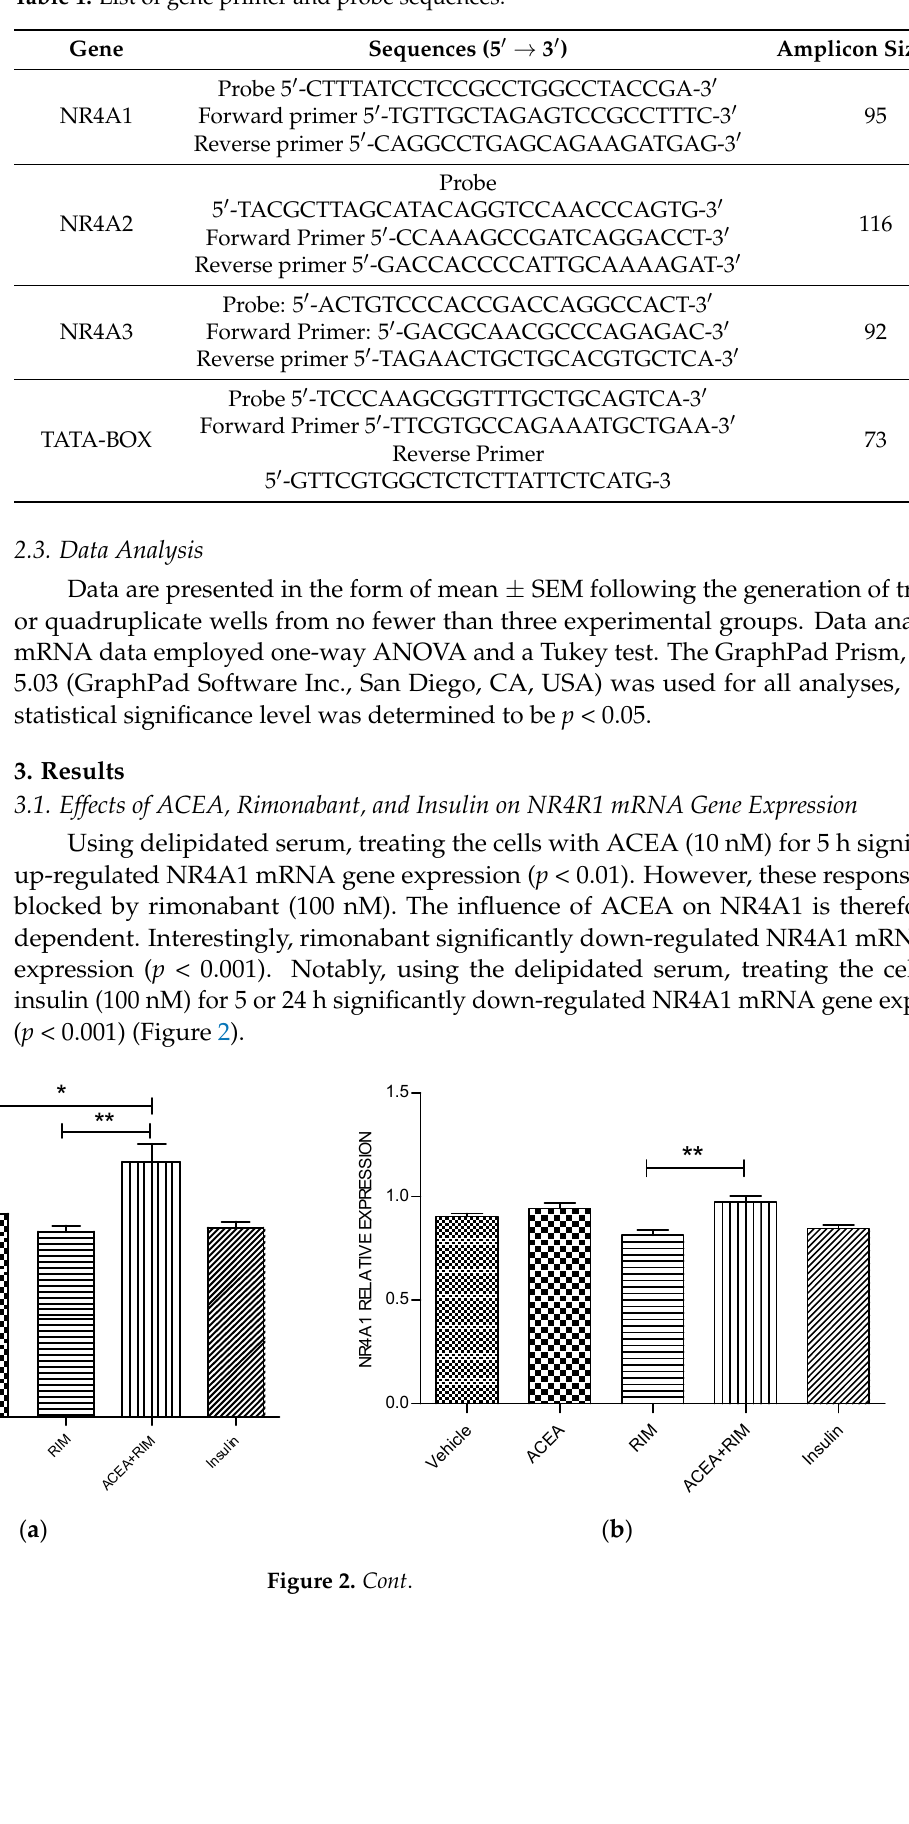
( d ) Figure 2. NR4A1 muscle myotubes—ACEA, rimonabant, ACEA and rimonabant, and insulin affect NR4A1 gene expres- sion; myotubes fed with delipidated serum. The stimulation time covered 3 to 24 h, and NR4A1 mRNA levels, relative to TATA-Box, was evaluated by quantitative real-time PCR (qRT-PCR) (100 nM). The following scenarios explain the stim- ulation process conducted: ( a ) Stimulation was done for 1 h. ( b ) Stimulation was done for 3 h. ( c ) Stimulation was ap- plied for up to 5 h. ( d ) Stimulation was applied for up to 24 h. The data were reported as the mean ± SEM of three sepa- rate groups. (n = 3; *denotes p < 0.05, **denotes p < 0.01, and ***denotes p < 0.001). Data were investigated by conducting one-way ANOVA test and Tukey test. NR4A1; nuclear receptor subfamily 4, group A, member 1. 3.2. Effects of ACEA, Rimonabant, and Insulin on NR4R2 mRNA Gene Expression Using delipidated serum, treating the cells with rimonabant (100 nM) for 24 h sig- nificantly down-regulated NR4A2 gene expression ( p < 0.05). By contrast, treating the cells with insulin for 1 or 3 h significantly down-regulated NR4A2 mRNA expression (Figure 3).